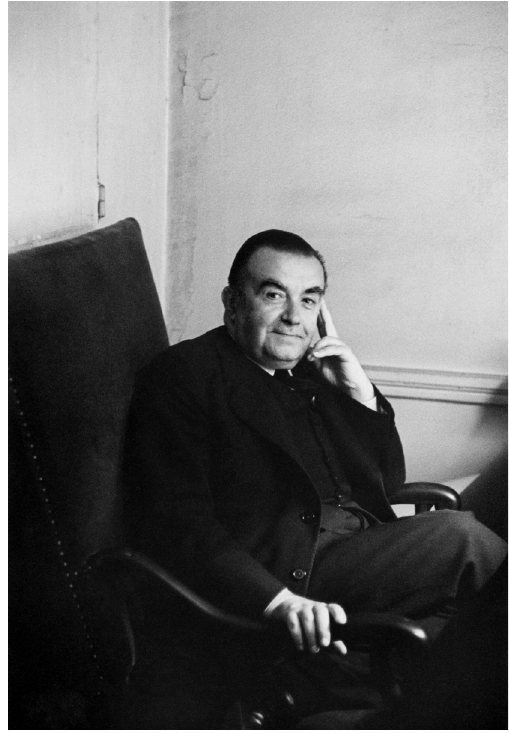
Fig. 1 Henri Cartier-Bresson, Tériade dans son bureau, rue Férou , © Henri Cartier- Bresson/Magnum